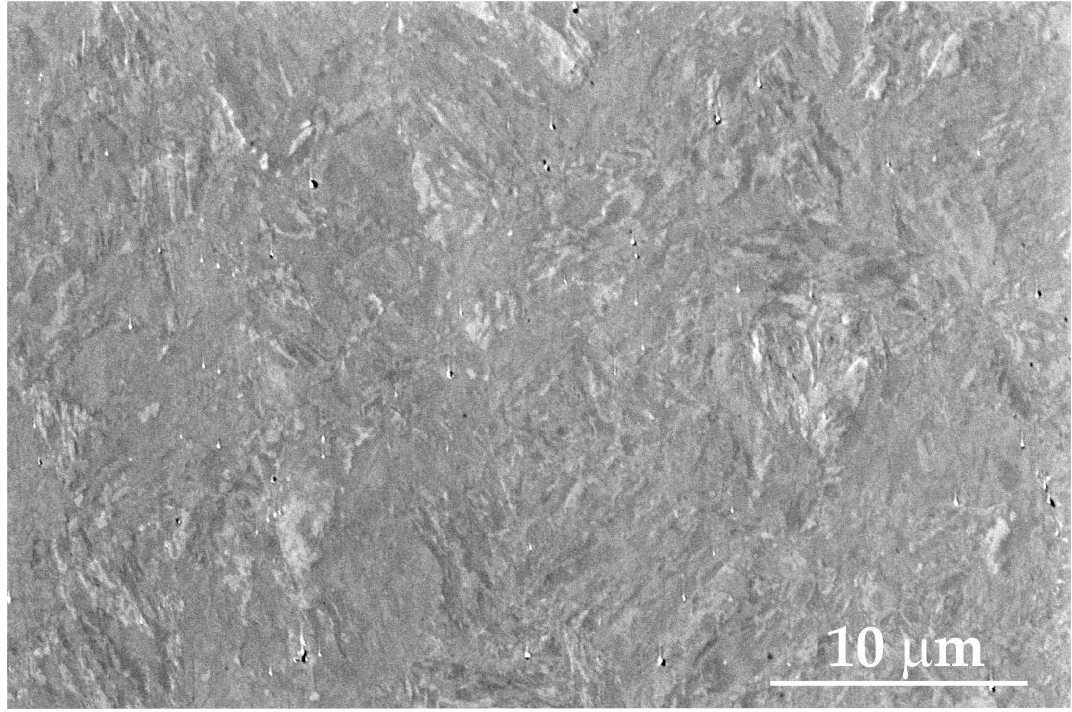
Figure 5. SEM picture of the surface of Armstal 550 steel with martensitic structure. On the surface of the metallographic sample, apart from the basic alloying elements, i.e., iron (Figure 6b,c), non-metallic inclusions of molybdenum and titanium (Figure 6d,e) were